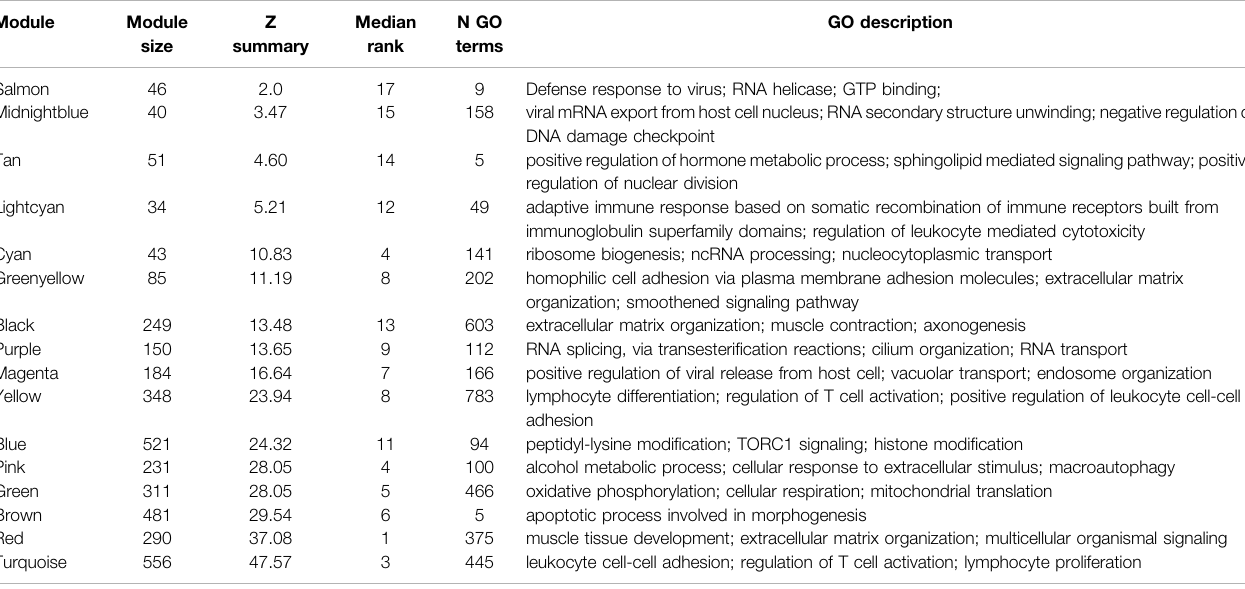
TABLE 2 | Select GO biological process terms in each of the modules present in the post-vitamin D network, with associated statistics for preservation in the pre-vitamin D network. The top three GO biological process terms for each module (determined by FDR p -value) are shown. Where highly similar terms related to overlapping genes existed (e.g., purine ribonucleoside binding and purine nucleoside binding) only one term is shown. Module